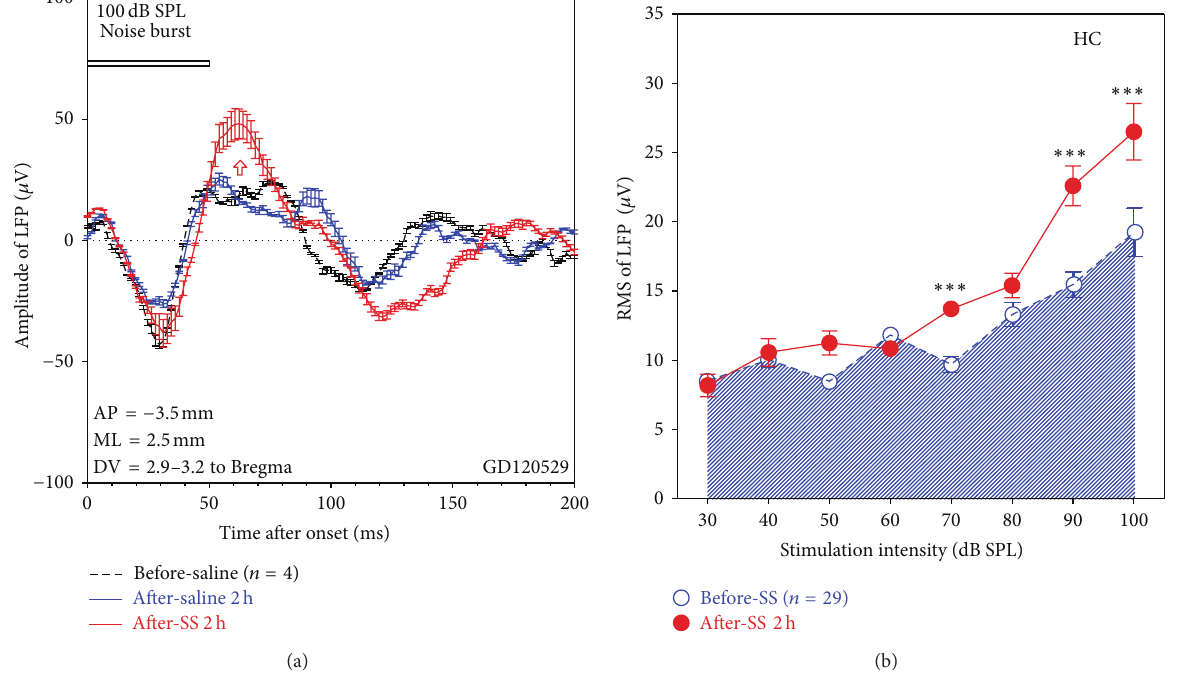
Figure 8: The effect of SS injection on noise-burst-evoked LFP elicited from electrodes in the hippocampus. (a) Averaged LFP ( 𝑛 = 4 recordings in one rat) at 100dB SPL recoded before treatment (black), after saline injection (blue), and after SS injection (red), showing a slight increase after SS injection. (b) Mean RMSs of LFP ( 𝑛 = 29 ) in a time window of 100ms as a function of stimulation level, showing enhancement at high stimulation levels. Stimulation: 50 ms noise burst; treatment: SS (250 mg/kg, i.p.). The vertical bars are SEs and the ∗∗∗ means 𝑃 < 0.001